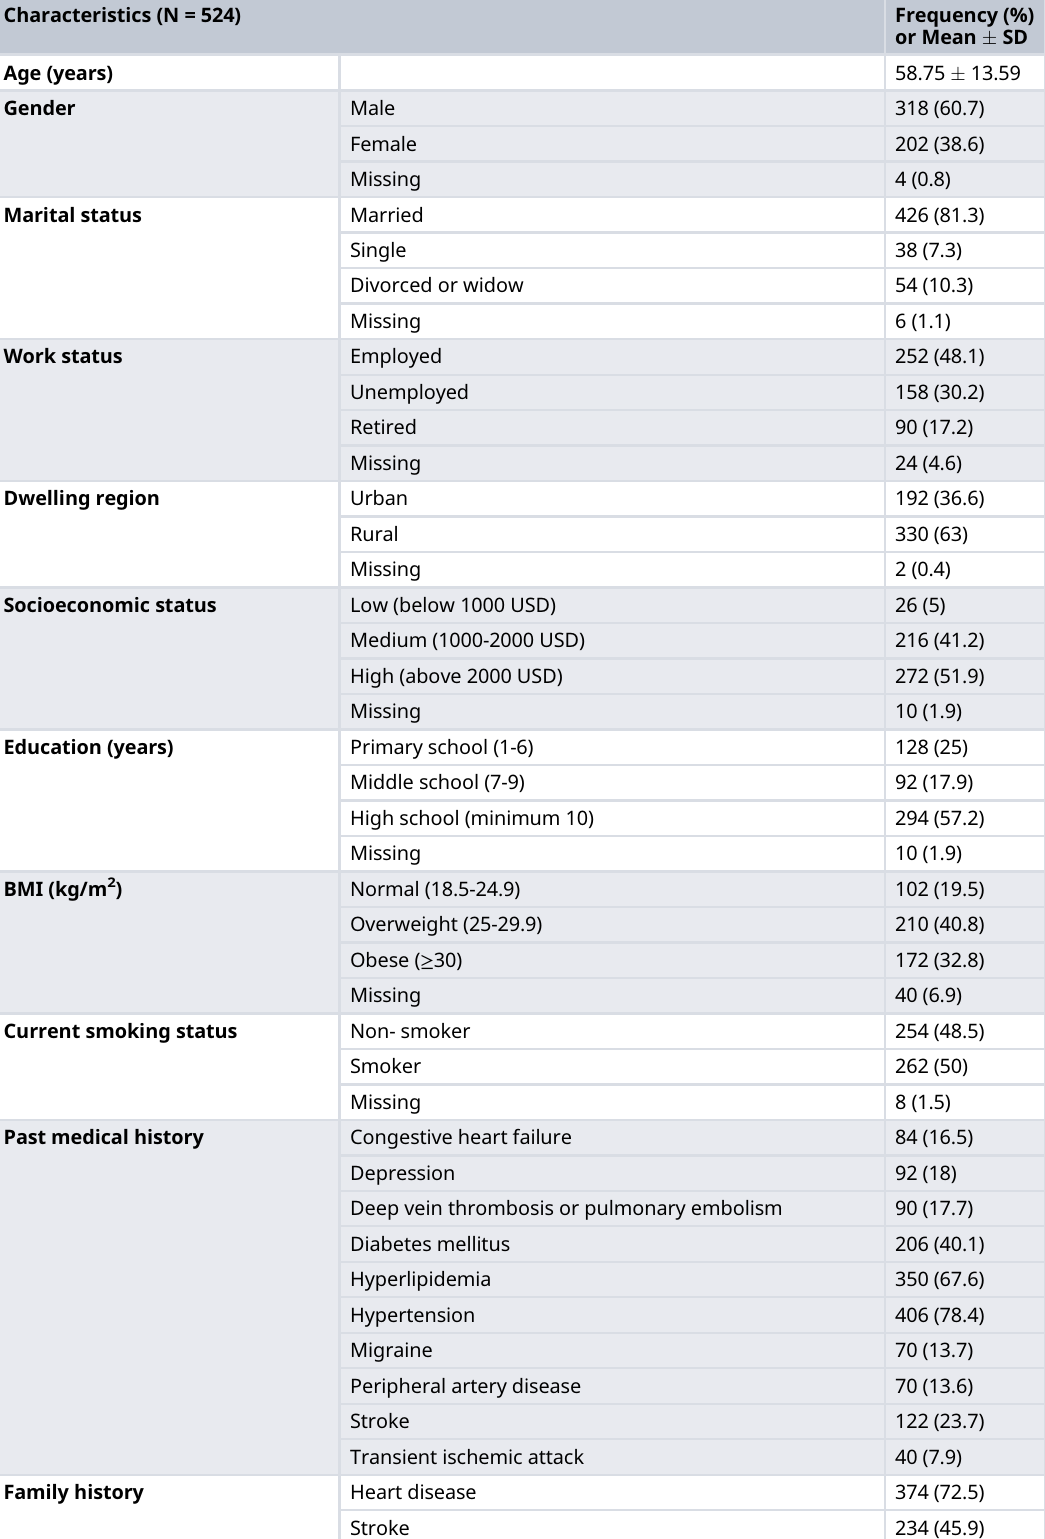
Table 1. Socio-demographic characteristics and past medical history of participants. Characteristics (N =